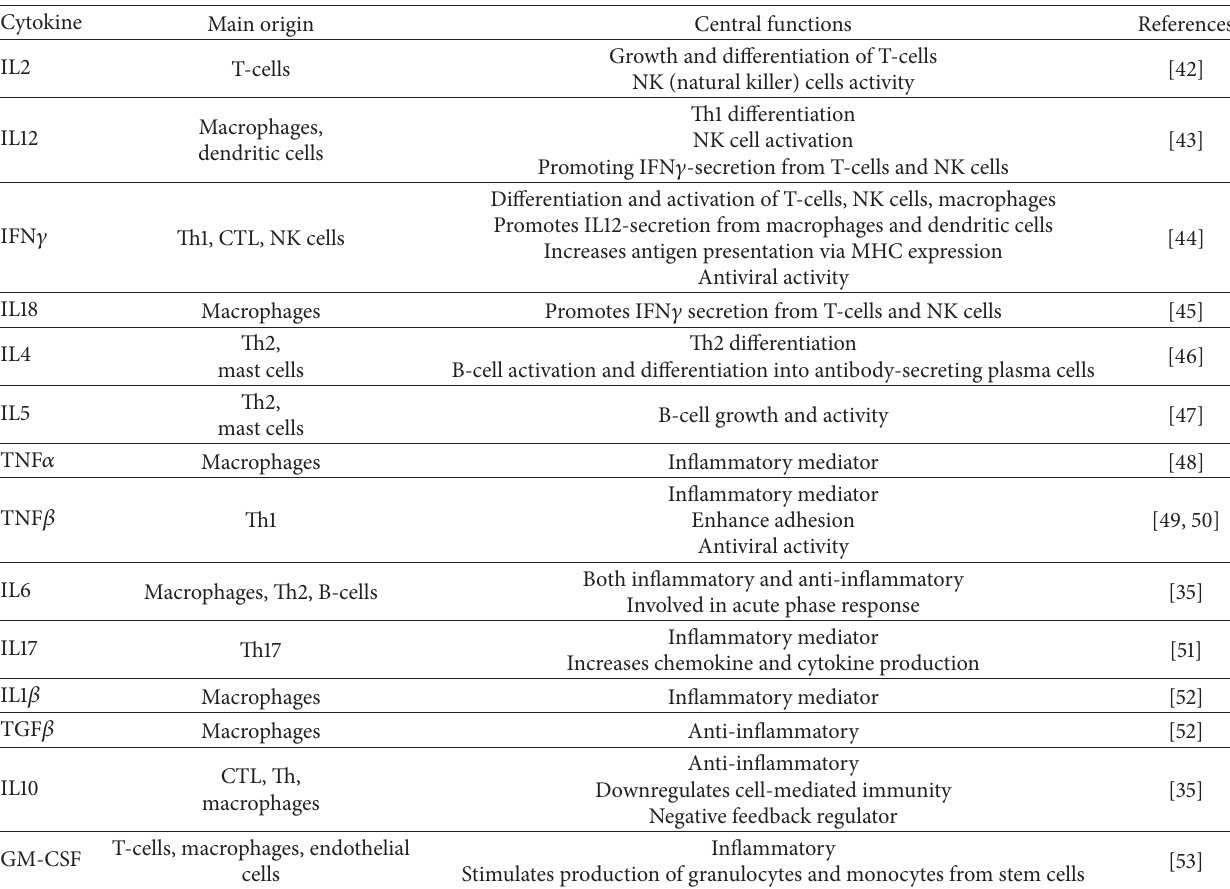
Table 1: Overview of cytokines included in this